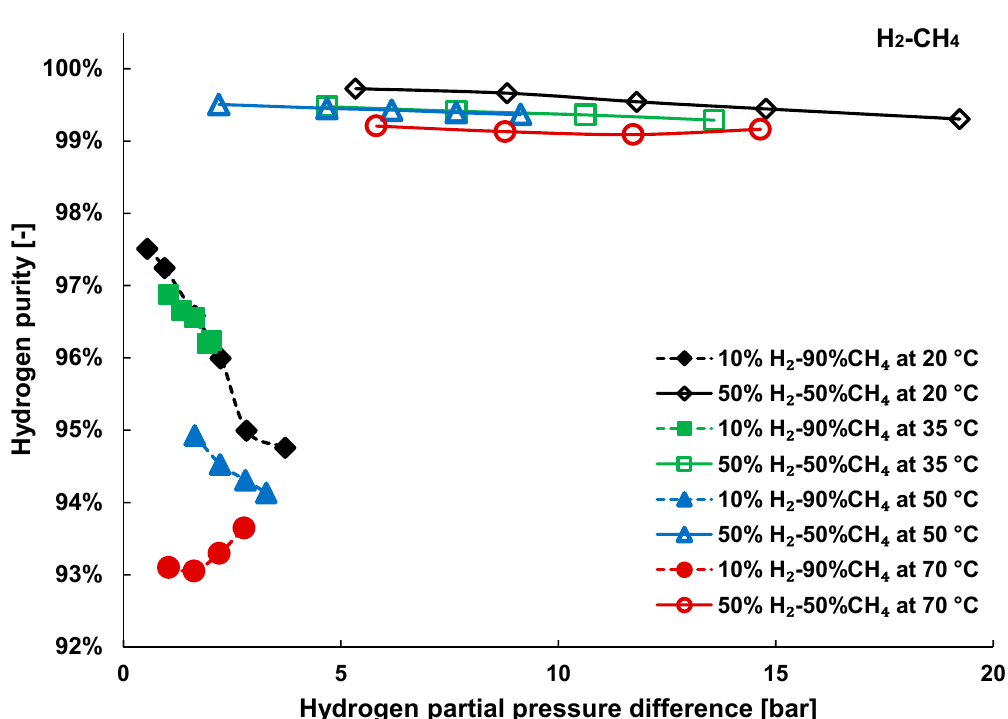
Figure 12. Comparison between hydrogen purity in a H 2 -CH 4 mixture with 10% and 50% hydrogen concentration at 20, 35, 50 and 70 °C, for CMSM-550.